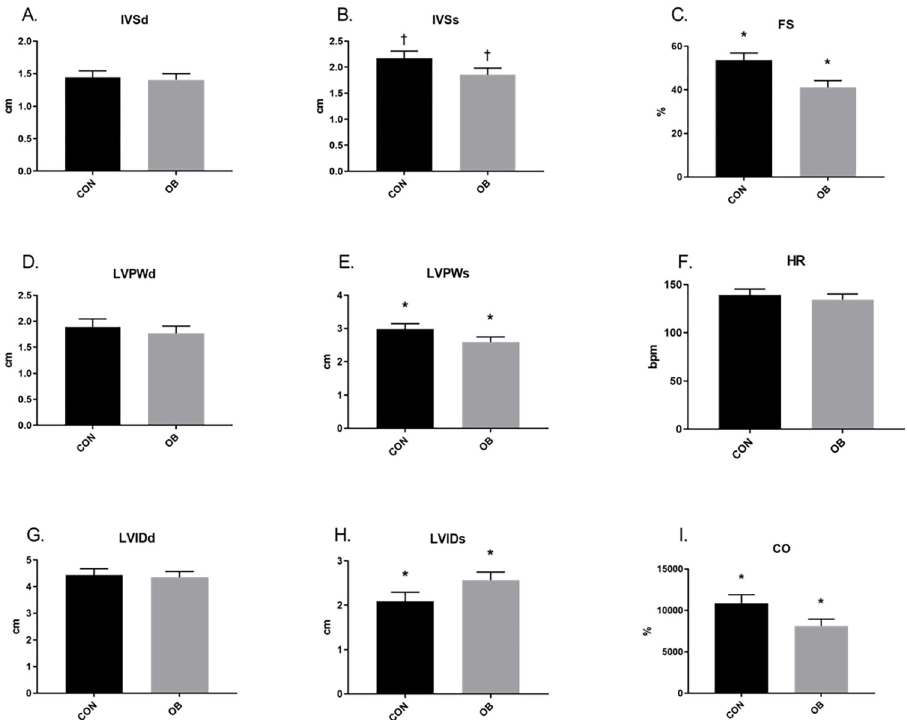
Fig 4. Short axis echocardiography results for 9-year-old F1 ewes. CONF1 (n = 5) and OBF1 (n = 8) ewes. Systolic and diastolic interventricular septum thickness (IVSs, IVSd). Systolic and diastolic left ventricle internal diameter (LVIDs, LVIDd). Systolic and diastolic left ventricle posterior wall thickness (LVPWs, LVPWd). Fractional shortening (FS). Heart rate (HR). Cardiac output (CO). † means show a trend (p < 0.1). � means differ (p < 0.05).